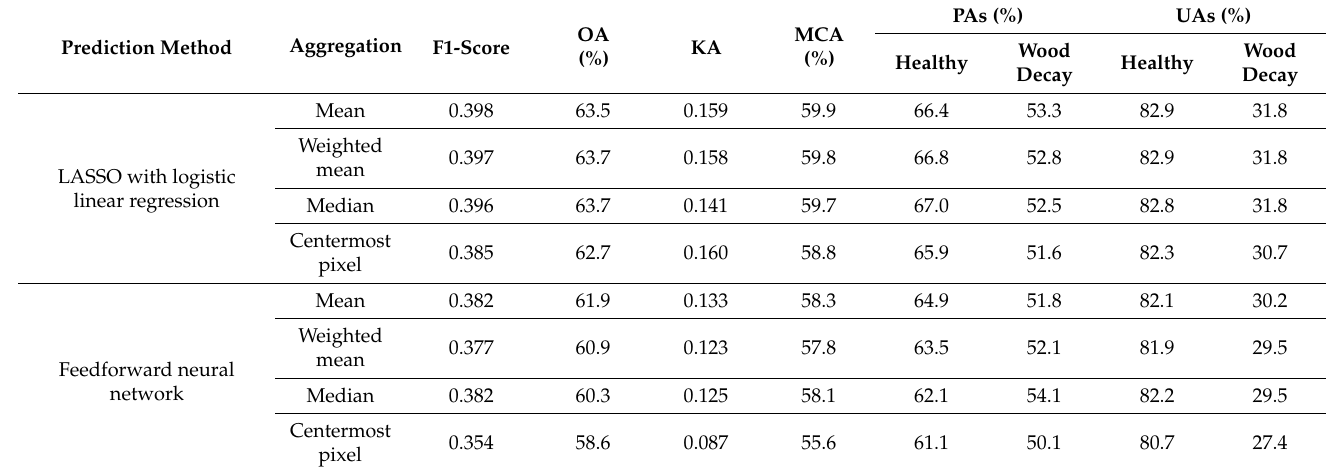
Table 1. Overall summary of the model performances with pixel aggregations for Dataset I.